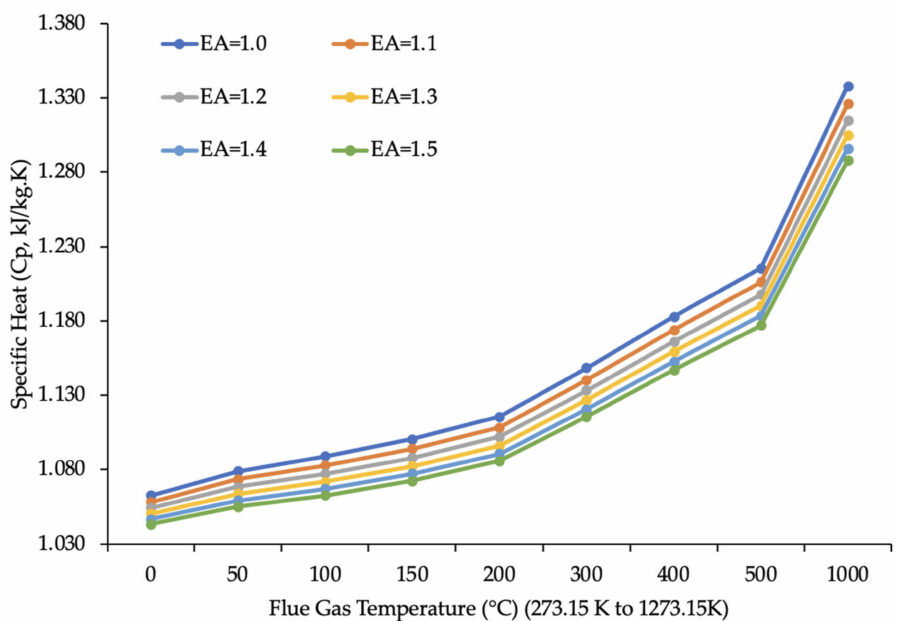
Figure 5. Specific heat of flue gas under various EA ratios and flue gas temperatures.